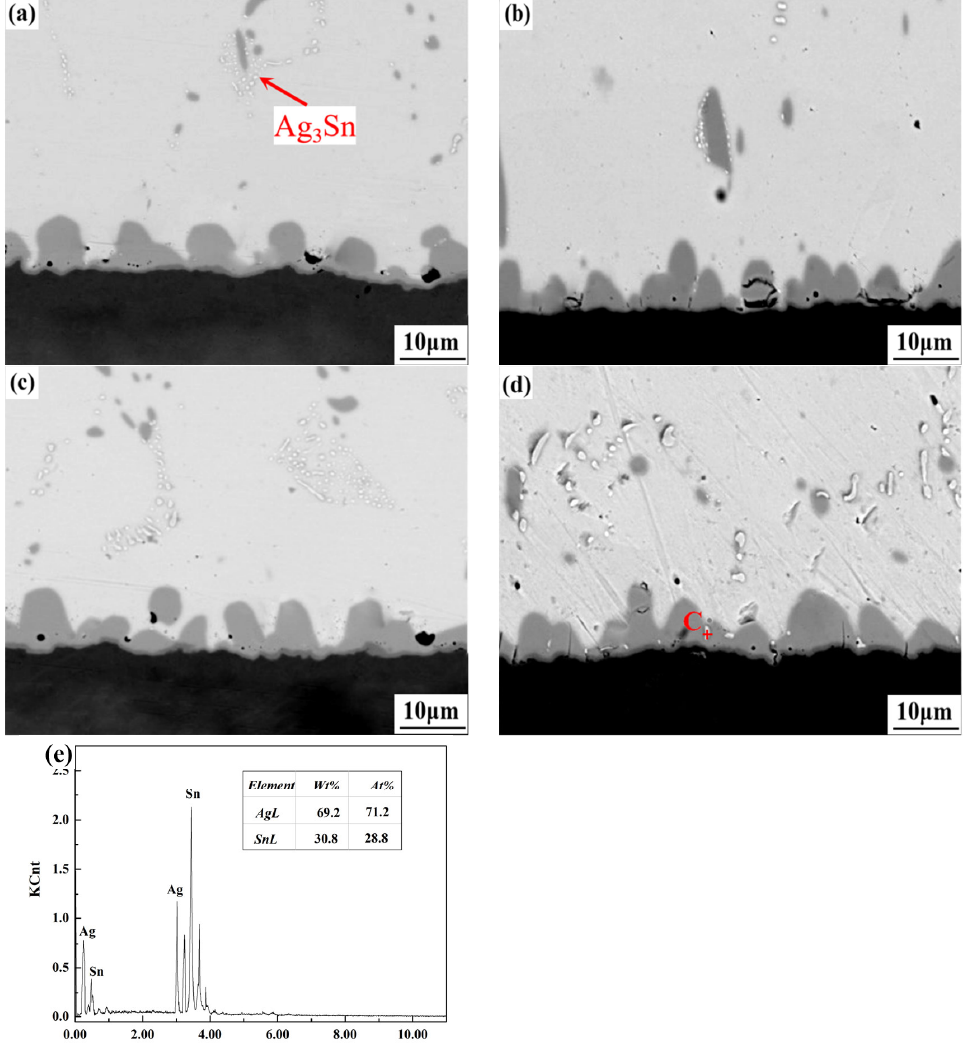
Figure 5. Interfacial microstructure of SAC105-(nano)Al 2 O 3 /Cu solder joint subjected to ( a ) 100 cycle; ( b ) 400 cycle; ( c ) 800 cycle; ( d ) 1000 cycle; ( e ) EDS analysis of point